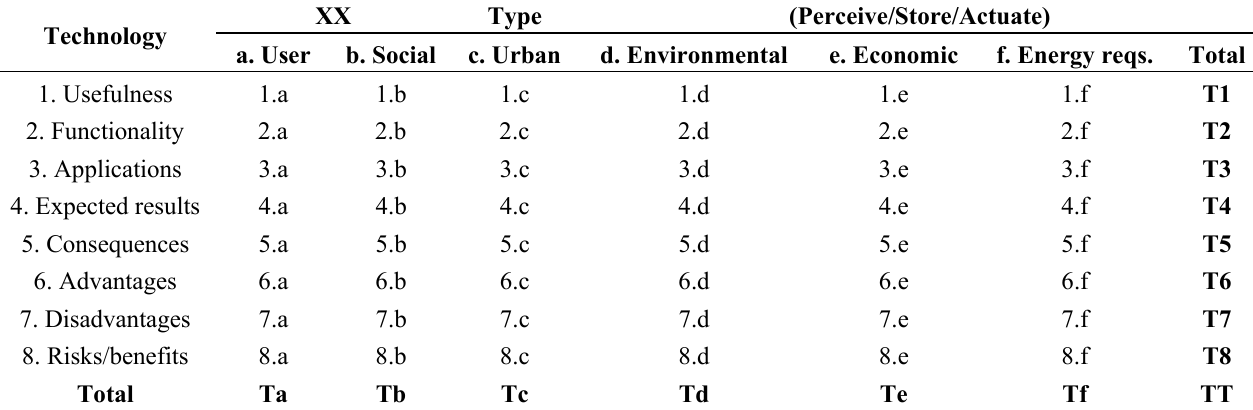
Table 1. Technologies Analysis Matrix (TAM) main concepts and qualification.